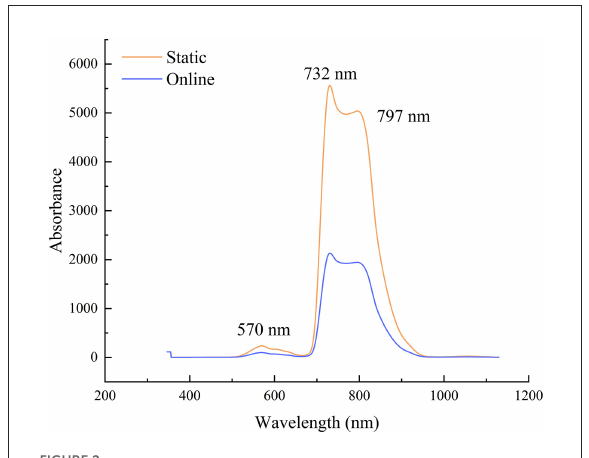
FIGURE2 Average Vis-NIR spectra of snow peach samples with static and online detection.